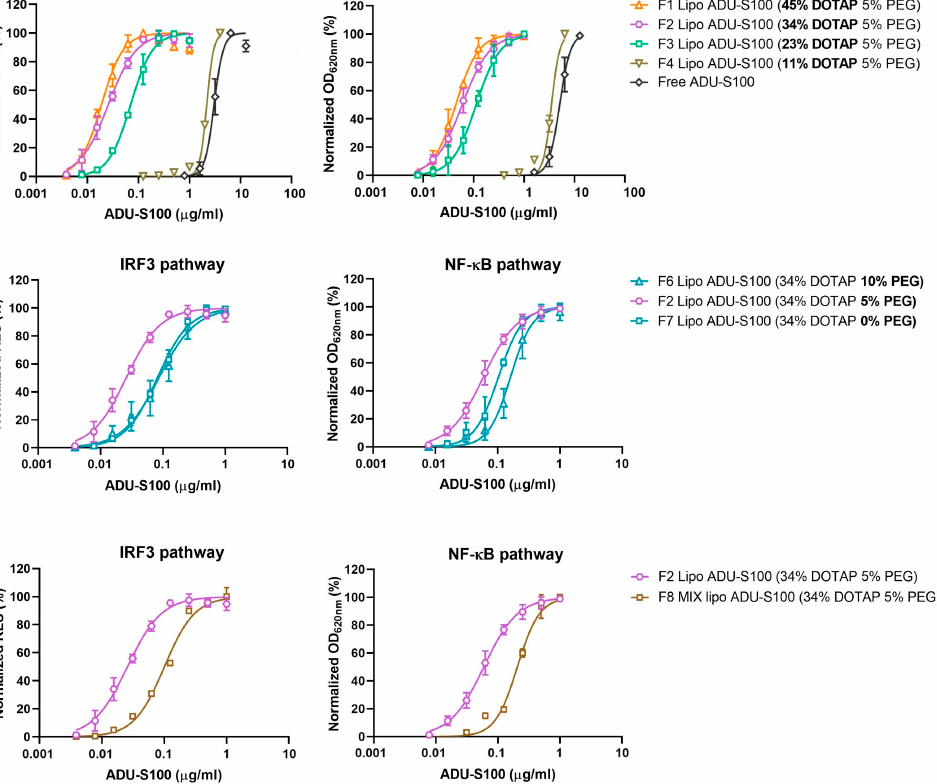
Figure 5. Formulation factors influencing STING activation by liposomal ADU-S100. Effects of DOTAP ( A ), PEGylation ( B ), and the drug loading method ( C ). THP-1 Dual cells were stimulated with free ADU-S100 or liposomal ADU-S100 formulations for 48 h. The cell culture medium was collected to determine the activation of the IRF3 and NF- κ B pathways by measuring the activities of Lucia luciferase and SEAP, respectively. The connecting lines are variable-slope dose–response curve fits. RLU: relative light units; OD: optical density. Data are shown as the mean ± SD ( n ≥ 3) and are representative of three independent experiments. Table 2. The EC 50 values of the IRF3 and NF- κ B pathways in the THP-1 Dual cell line treated with free or liposomal ADU-S100.